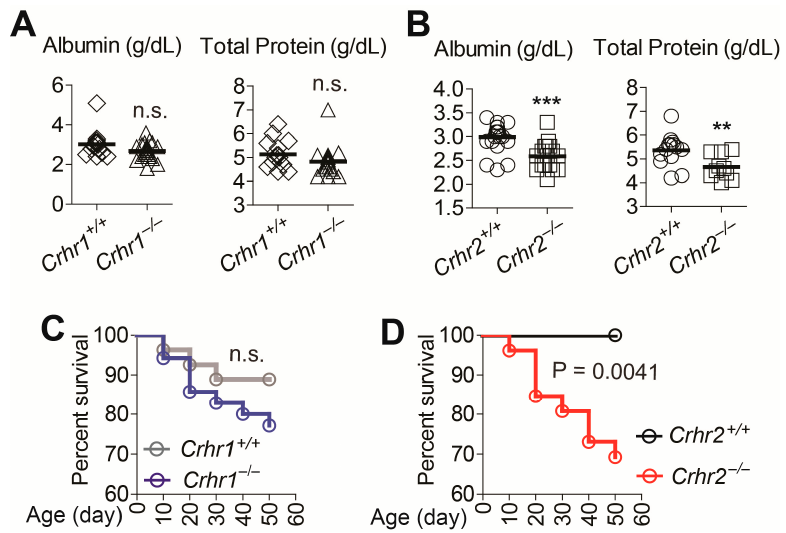
Figure 6. Crhr2 deficiency exacerbates the severity of intestinal tumorigenesis in the AOM/DSS- treated mice. ( A , B ) Serum albumin and total protein were analyzed using mouse blood samples. Horizontal bar in each graph indicates mean. ** p < 0.01, *** p < 0.001, (Mann–Whitney U test). Crhr1 +/+ (n = 15), Crhr1 − / − (n = 20–24), Crhr2 +/+ (n = 14–21), and Crhr2 − / − (n = 10–17). ( C , D ) Difference in survival was analyzed by Kaplan–Meier plot. The log-rank (Mantel–Cox) test was used to compare significant survival difference ( p = 0.0041 in D ). n.s. stands for not significant. Crhr1 +/+ (n = 28), Crhr1 − / − (n = 35), Crhr2 +/+ (n = 23), and Crhr2 − / − (n = 26). Data were analyzed with the results accumulated by 5 independent experiments.